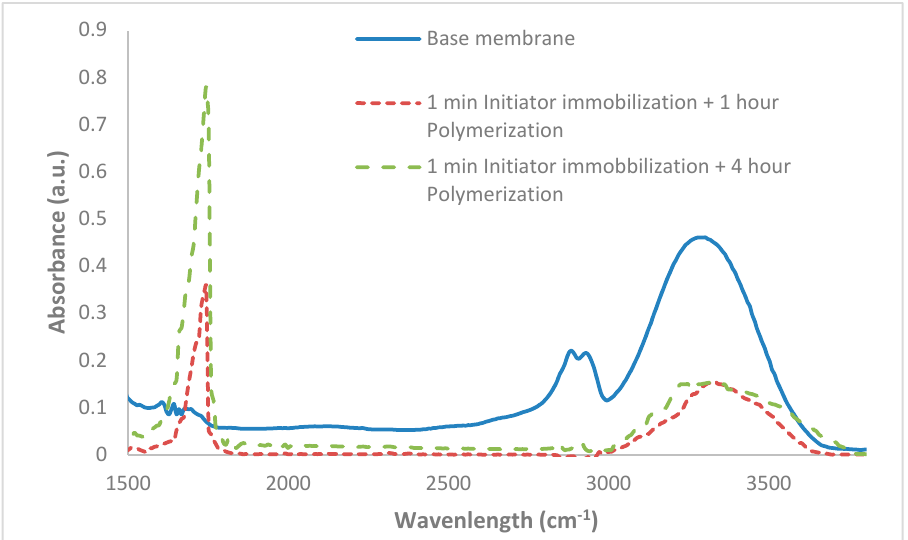
Figure 3. Fourier Transformed Infrared ( FTIR) spectra for base and modified membranes. Initiator was immobilized on the inner pore and outer membrane surface, followed by polymerization for 1 and 4 h.